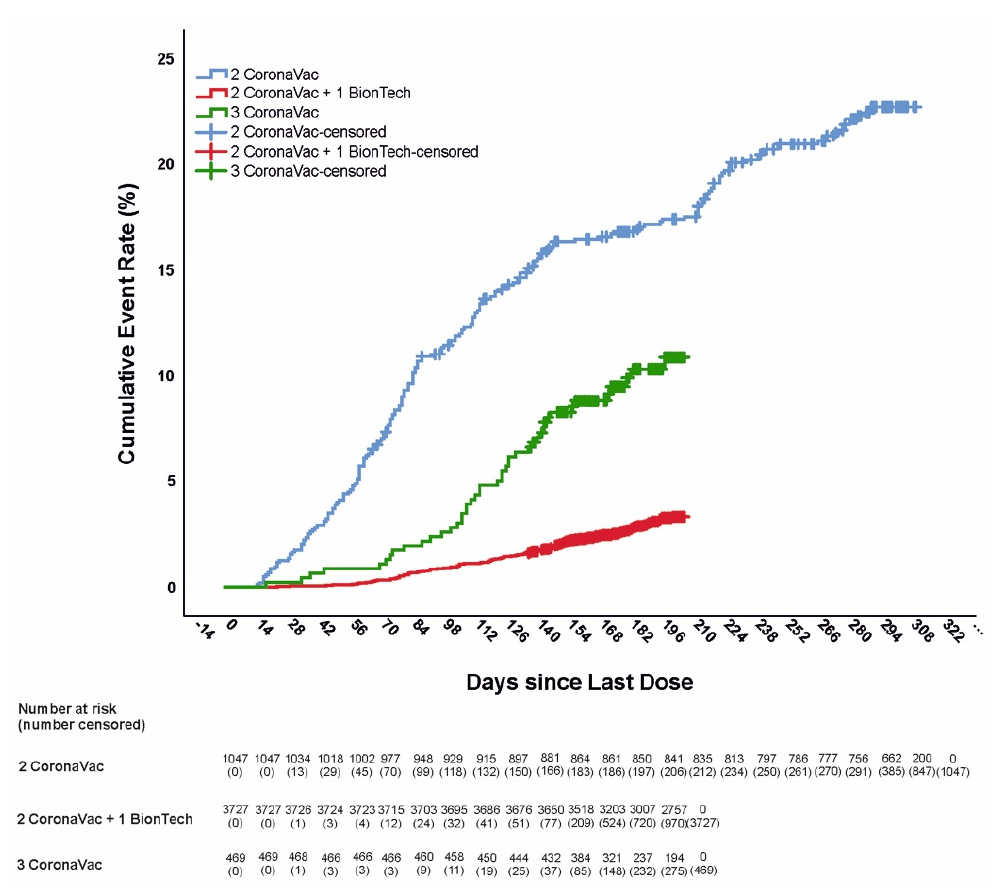
Figure 2. Cumulative incidence of SARS-CoV-2 infection categorized by vaccination status assessed from 2 weeks after receipt of the last dose of vaccine.